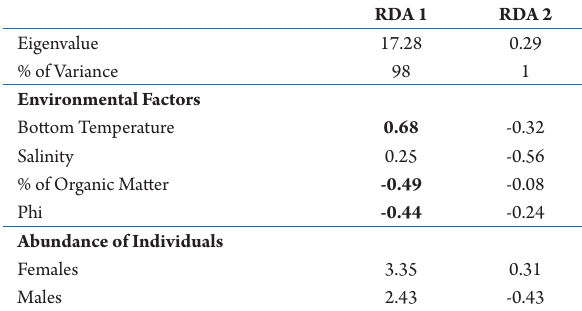
Bold values denote those variables that were considered to the biologically meaning for that RDA axis (i. e. > 0.4 and <-0.4) Rakocinski et al . (1996).